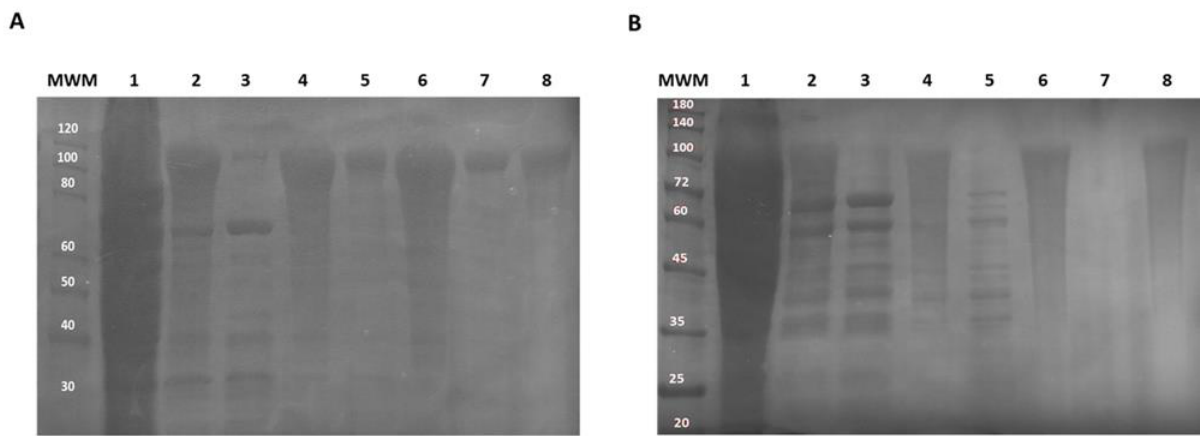
Figure 3. SDS-PAGE of purification by inverse transition cycling for ( A ) CM4DP-A200 and ( B ) SynDP-A200. After sonication of the crude extract (lane 1), lysates were adjusted to pH 3.5 and the precipitates were removed by centrifugation. The supernatants (lane 2) were subjected to three purification cycles of hot and cold incubation and centrifugation steps (lanes 3–8). Due to the thermoresponsive behaviour of A200, both CM4DP-A200 and SynDP-A200 self-assembled and precipitated during incubation in the hot cycle, leaving the contaminants in the supernatant. Lanes 3, 5 and 7 correspond to the supernatants obtained from the first, second and third hot spins, respectively. Lanes, 4, 6 and 8 correspond to the protein-enriched fractions of CM4DP-A200 and SynDP-A200. MWM corresponds to the molecular weight marker in kDa.